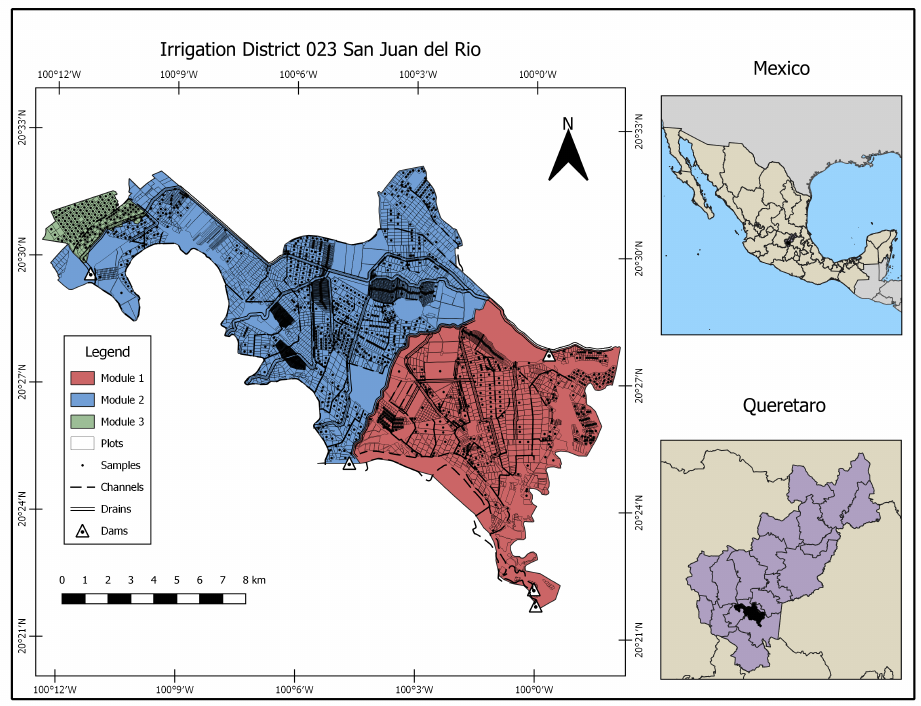
Figure 2. Location map of the sampling points in Irrigation District 023 San Juan del Río,